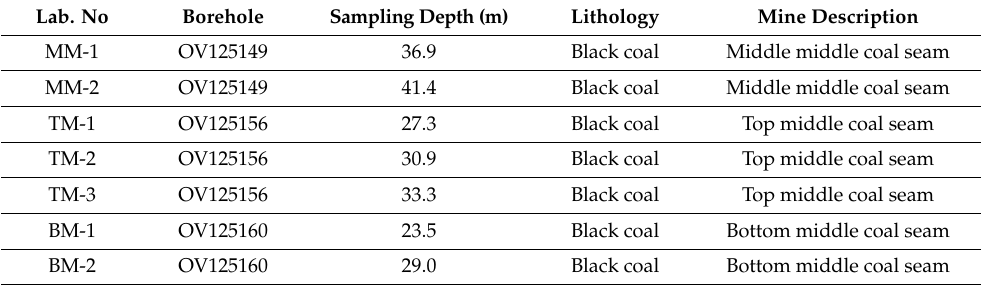
Table 1. Description of the coal samples analyzed for the maceral